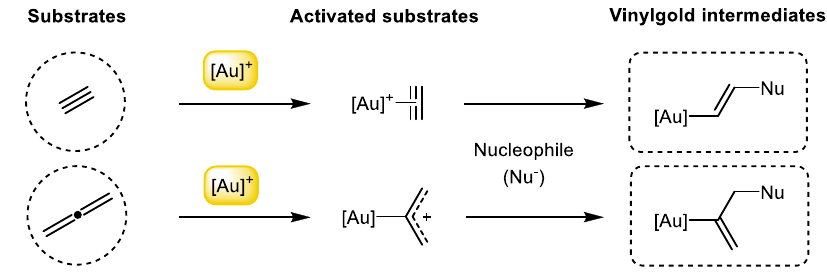
Figure 2. Vinylgold intermediates proposed in gold(I) catalyzed transformations.